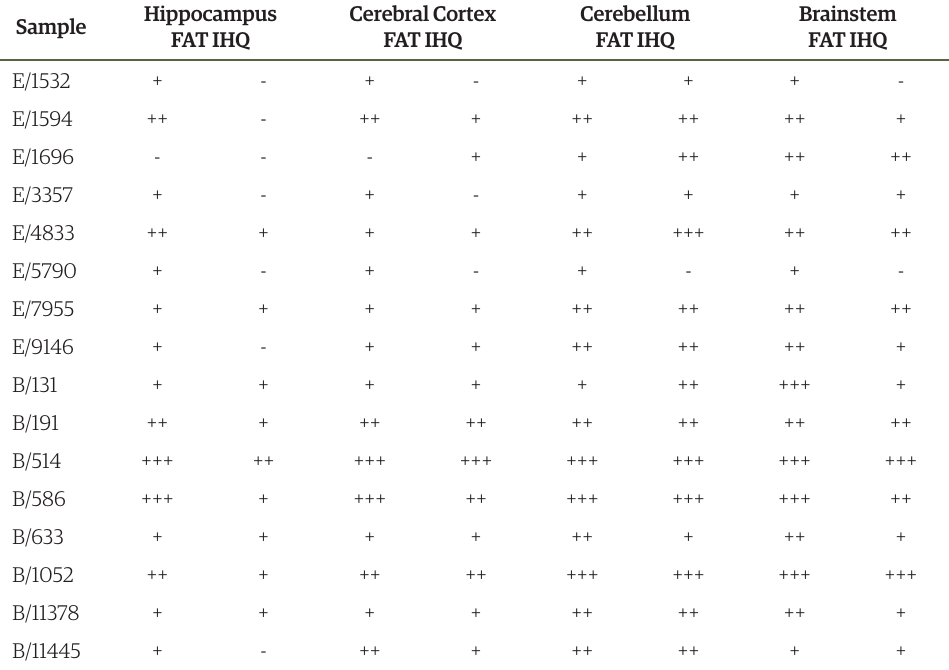
Table 3. Distribution of antigenic rabies virus in samples of equines and bovines SNC submitted to tests